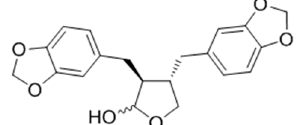
Figure 34. Structure of ( − )-cubebin. Figure 33. Structure of kavalactones and glucosylsterols isolated from the rhizome extract of Piper methysticum .